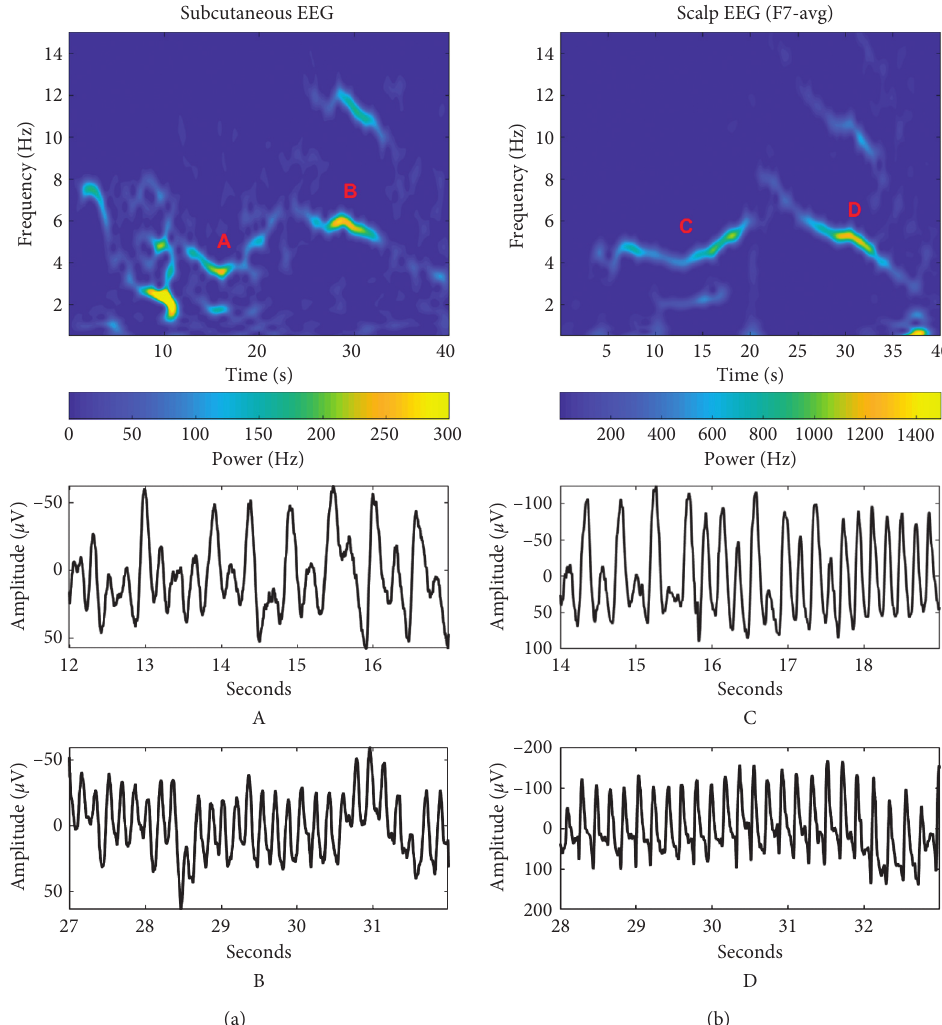
Figure 4: Persistent seizure signature. Comparison of two focal seizures recorded with one year in between from subcutaneous EEG (a) and scalp EEG (b). Time-frequency-power plots of 40 seconds are shown in the top. We see the same overall frequency dynamics between the two, but the subcutaneous device records with lower power and the seizure has more mixed frequencies in the early part. For each seizure, the letters designate different time-domain magnifications shown below for approximately the same corresponding part of the spec- trographical signature. At around 15 seconds, 4-5Hz activity can be observed. Around 30 seconds, 5-6 Hz activity with a sharper morphology in the time-domain is visible, mirrored by the higher-frequency subharmonic visible in this part of the